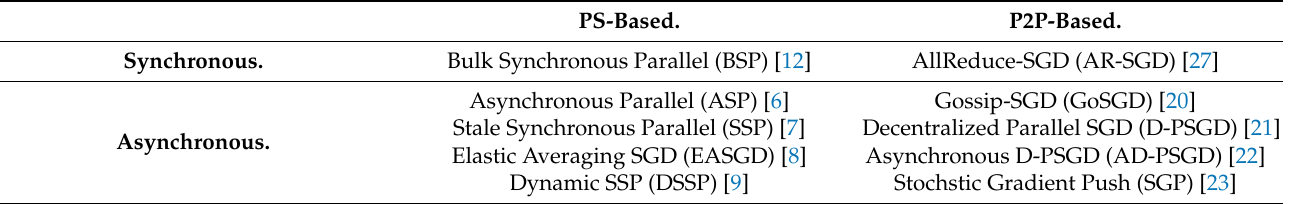
Table 1. Existing data-parallel distributed training algorithms.